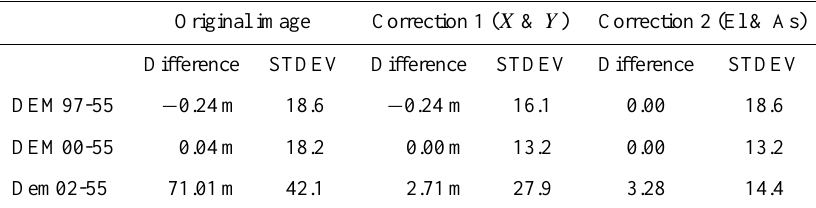
Table 5. Assessing the DEMs accuracy before and after corrections (on rocky areas).